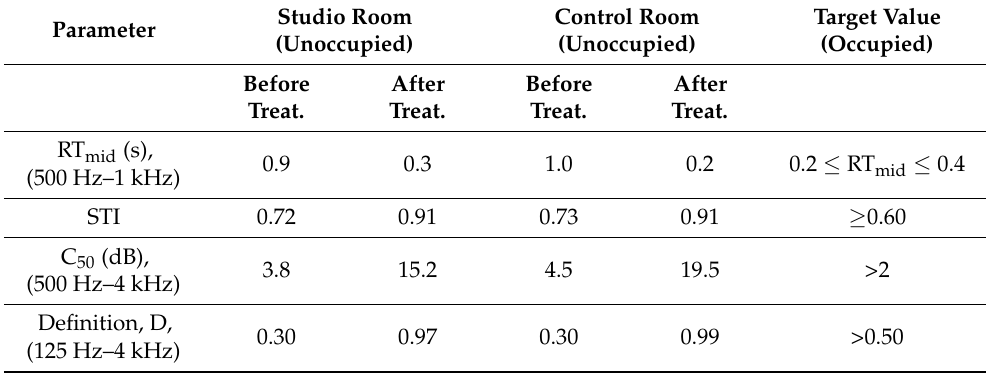
Table 12. Comparison of the acoustic parameters of the rooms. Parameter